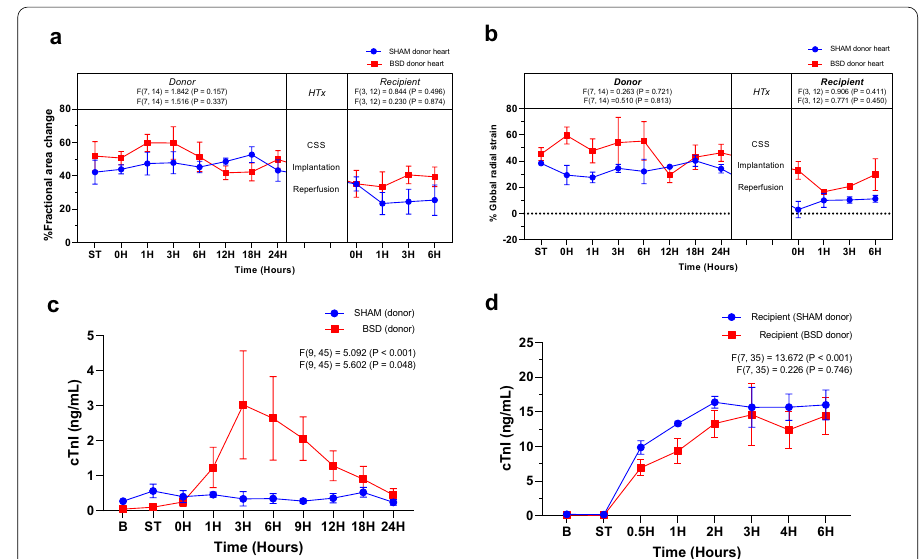
Fig. 7 Cardiac function in donors (pre‑HTx) and recipients (post‑HTx). Cardiac function as determined by changes in a % fractional area change and b % global radial strain by two‑dimensional speckle tracking echocardiography. Cardiac damage was assessed by cardiac troponin I (cTnI, ng/mL) levels in plasma of c donors and d recipients. Data are expressed as mean SEM, n 4/group. Top F and p values on each graph ± = represent effect of time, and bottom F and p values represent differences between BSD vs. sham over time. B Baseline, ST stabilisation 1 h following completion of instrumentation procedures, 0H in donor—confirmation of BSD, 0H in recipient—successful weaning from